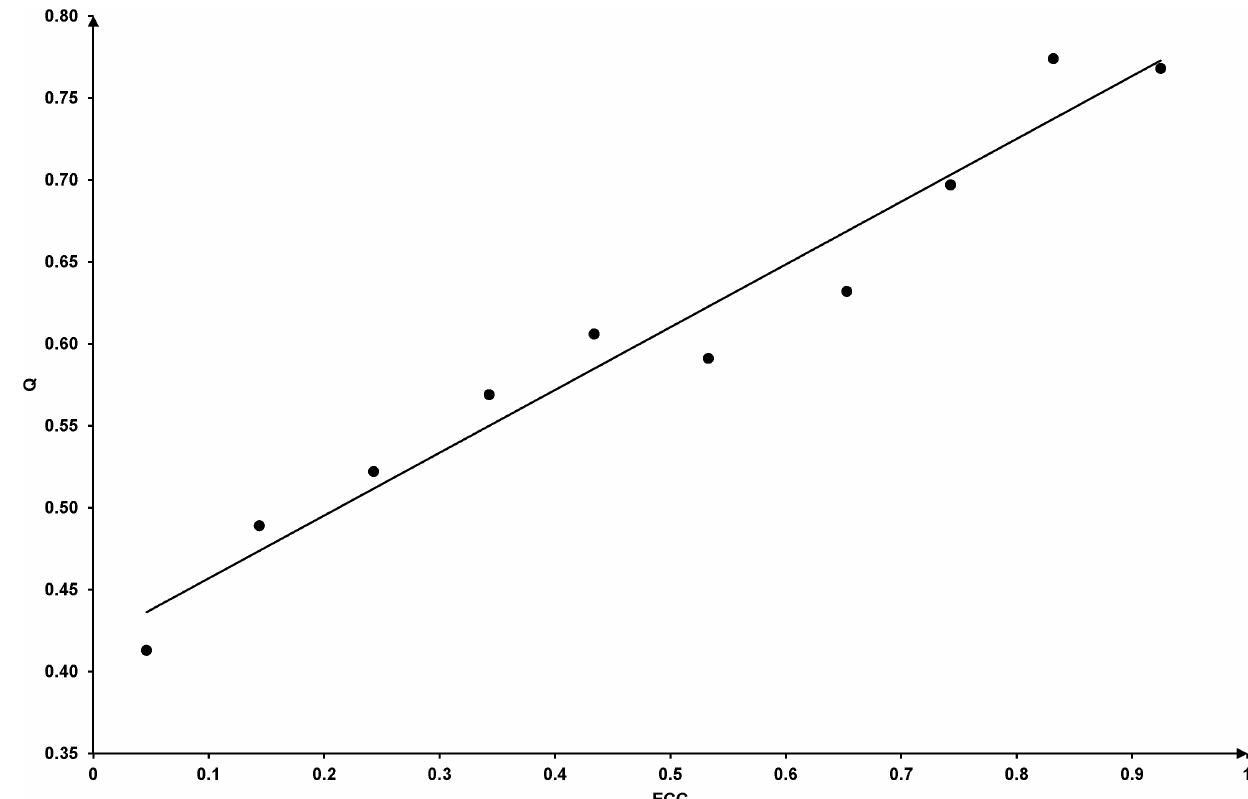
Figure 2. The relationship between ECC and co-localization scores. For every pair of interacting proteins with experimentally annotated subcellular locations, the ECC of their interactions and the co-localization score were computed. These interactions were divided into ten groups according to their ECC values. The first group contained the interactions with ECC value between 0 and 0.1.The second group contained the interactions with ECC value between 0.1 and 0.2. The third group contained the interactions with ECC value between 0.2 and 0.3, and so forth. The average values of ECC and co-localization score were computed for every group. The horizontal axis of this figure is the average value of ECC. The vertical axis of this figure is the average value of co-localization score. Ten dots were plotted on this figure to represent the ten groups of interactions. A straight line was generated using simple linear regression method to represent the linear relationship between the average ECC and the average co-localization score.